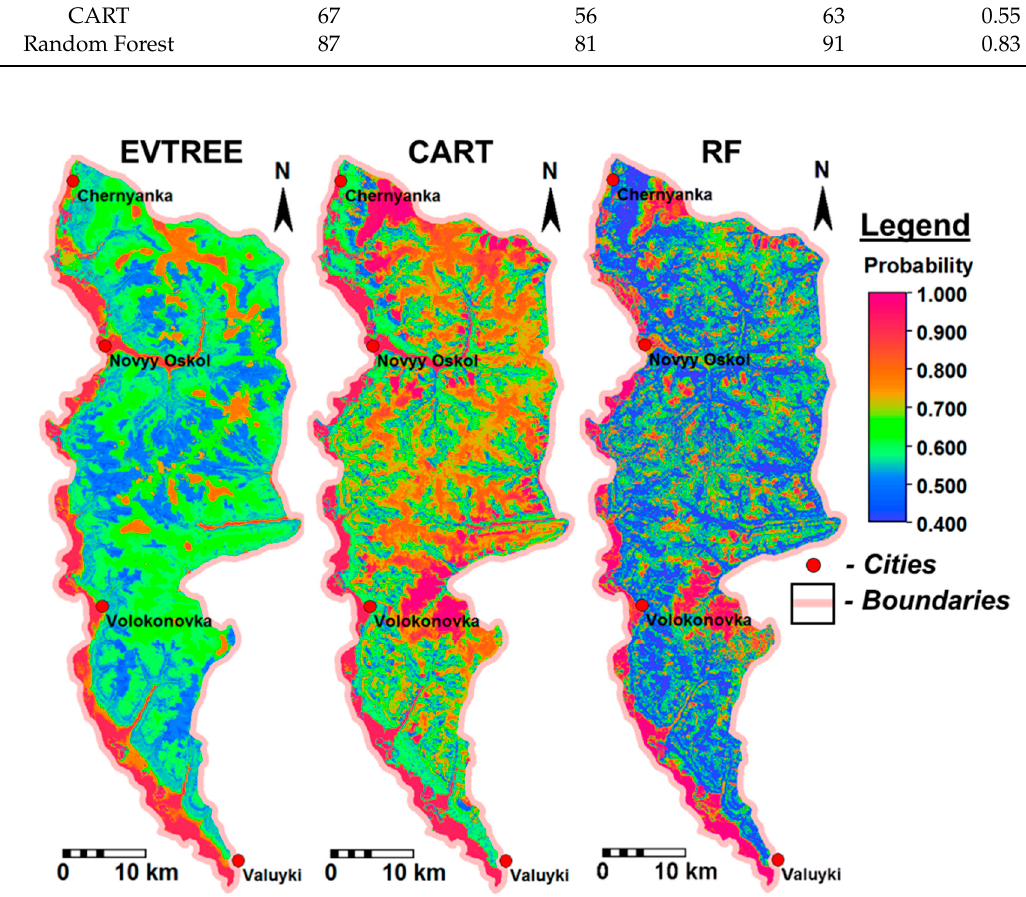
Table 6. Accuracy of the soil maps after reducing the size of the training sample set.